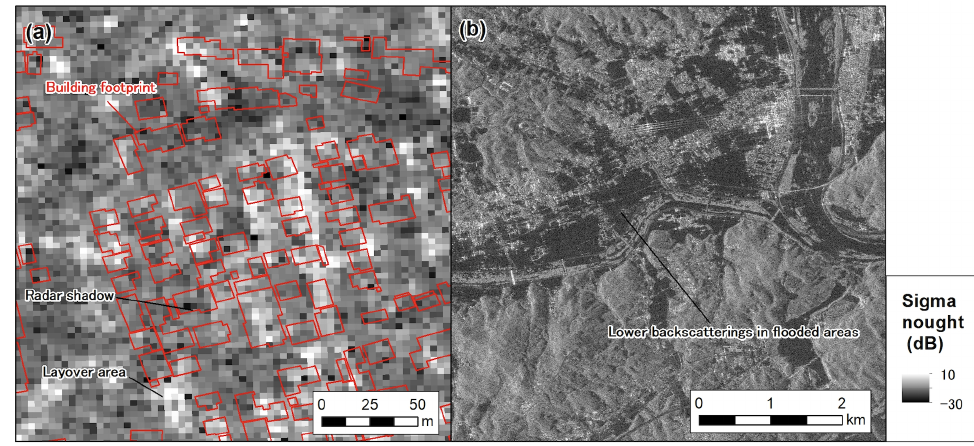
Figure 4. Zoomed image of ALOS-2/PALSAR-2 data: ( a ) built-up area and ( b ) flooded area.